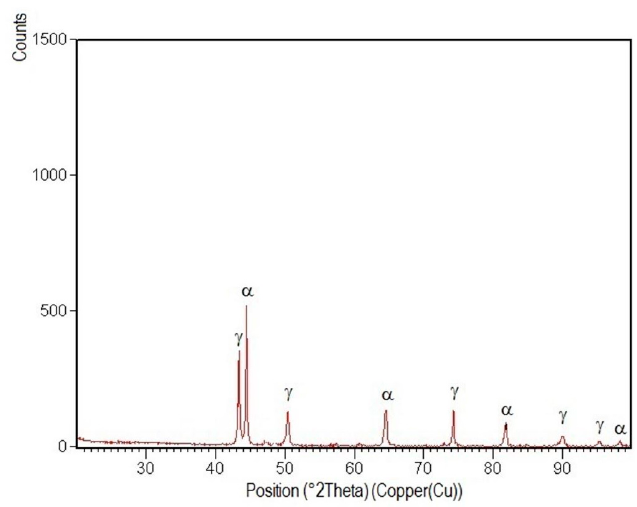
Figure 12. XRD pattern of the welded joint root layer realized with E l = 6.9 kJ/cm.